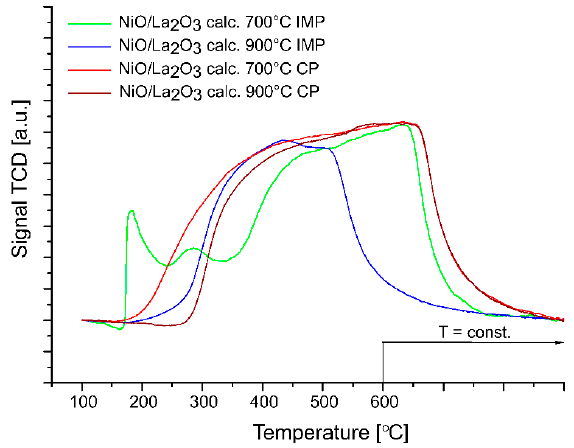
Figure 4. The temperature programmed desorption of ammonia profiles recorded for NiO/La 2 O 3 catalysts reduced in hydrogen atmosphere for 1 h at 500 °C.